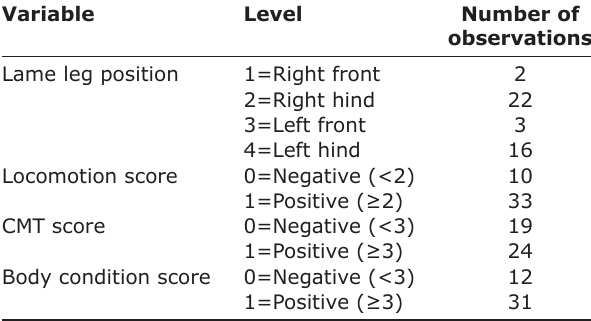
Table-2: Descriptive statistics of variables of interest that were considered in the analysis for association of claw disorders with subclinical IMIs diagnosed by CMT in Egyptian dairy cows.